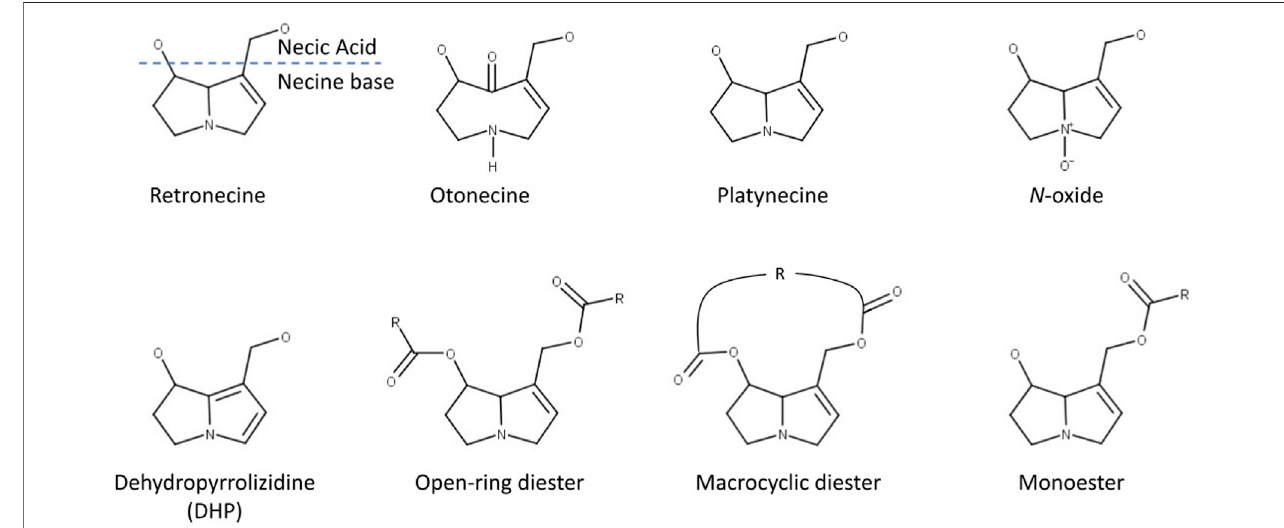
FIGURE 1 | Structural features of pyrrolizidine alkaloids (modi fi ed after Schöning et al., 2017).